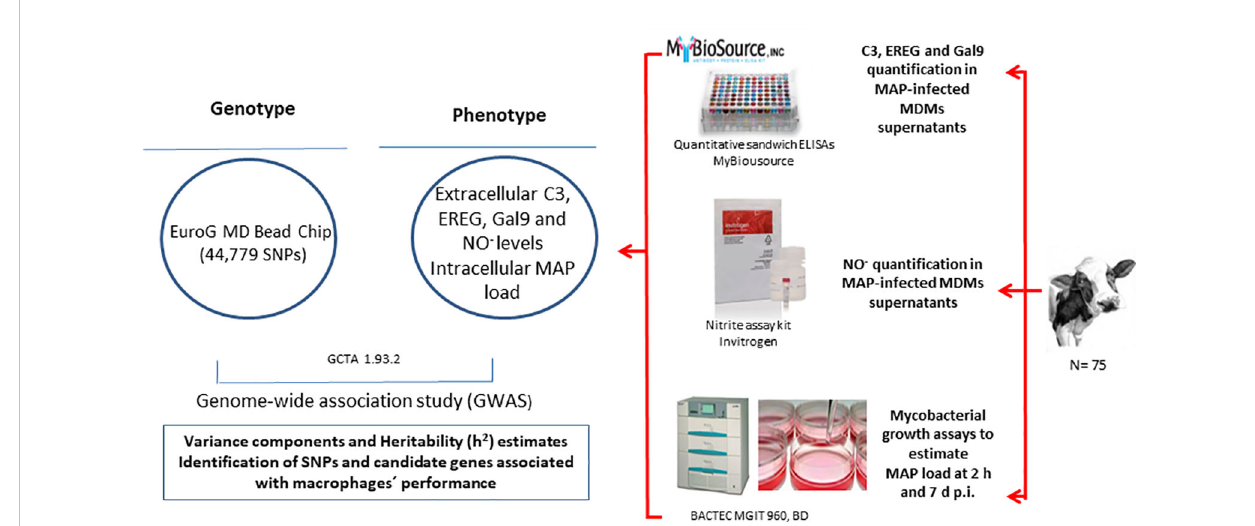
FIGURE 1 Study design. The approach starts from the measures of MAP load within MAP infected-MDMs and the C3, EREG, Gal9, and NO - expression levels in the supernatants of MAP-infected-MDMs. These phenotypes are combined with the genotypes of the animals in a GWAS study for the calculation of variance components and heritability (h 2 ) estimates and the identi fi cation of associated SNPs and candidate